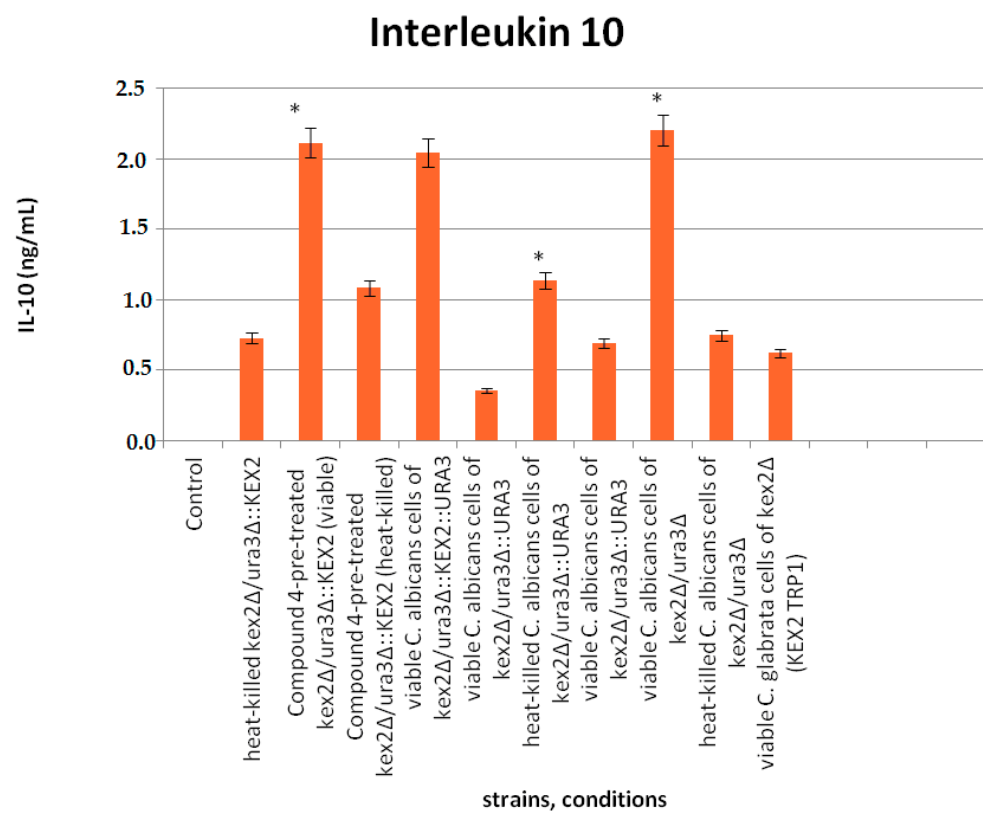
Figure 5. Production of IL-10 upon interaction of peripheral blood mononuclear cells PBMCs with the Candida mutant cells in the presence or absence of Compound 4 at 0.25 µg/mL. Legend: * stands for statistically significant differences between the viable mutants and their heat-killed counterparts in IL-10 induction. All data are presented as mean values ± standard deviations (SDs).